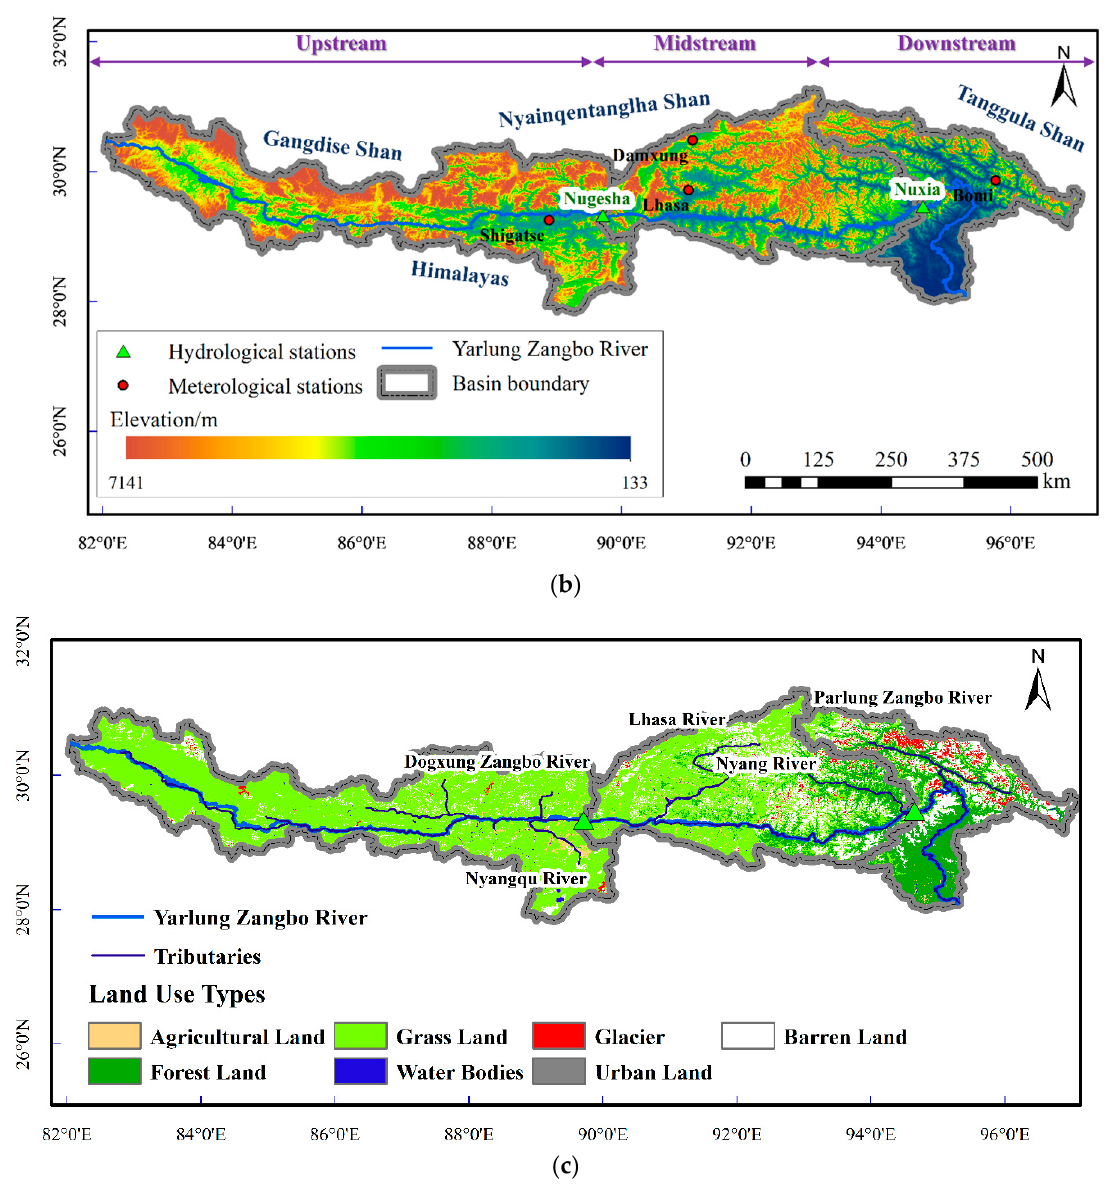
Figure 1. The geographical location ( a ), hydrometeorological stations ( b ) and land use types in 2005 ( c ) of the Yarlung Zangbo River (YZR) basin. The elevation and land use data were downloaded from the Resource and Environment Data Cloud Platform [57] .